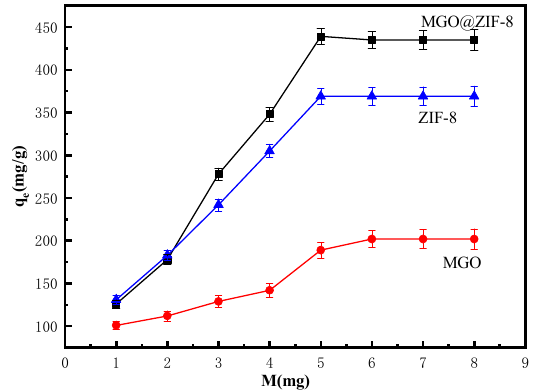
Figure 10. Effect of amount of adsorbent on adsorption.